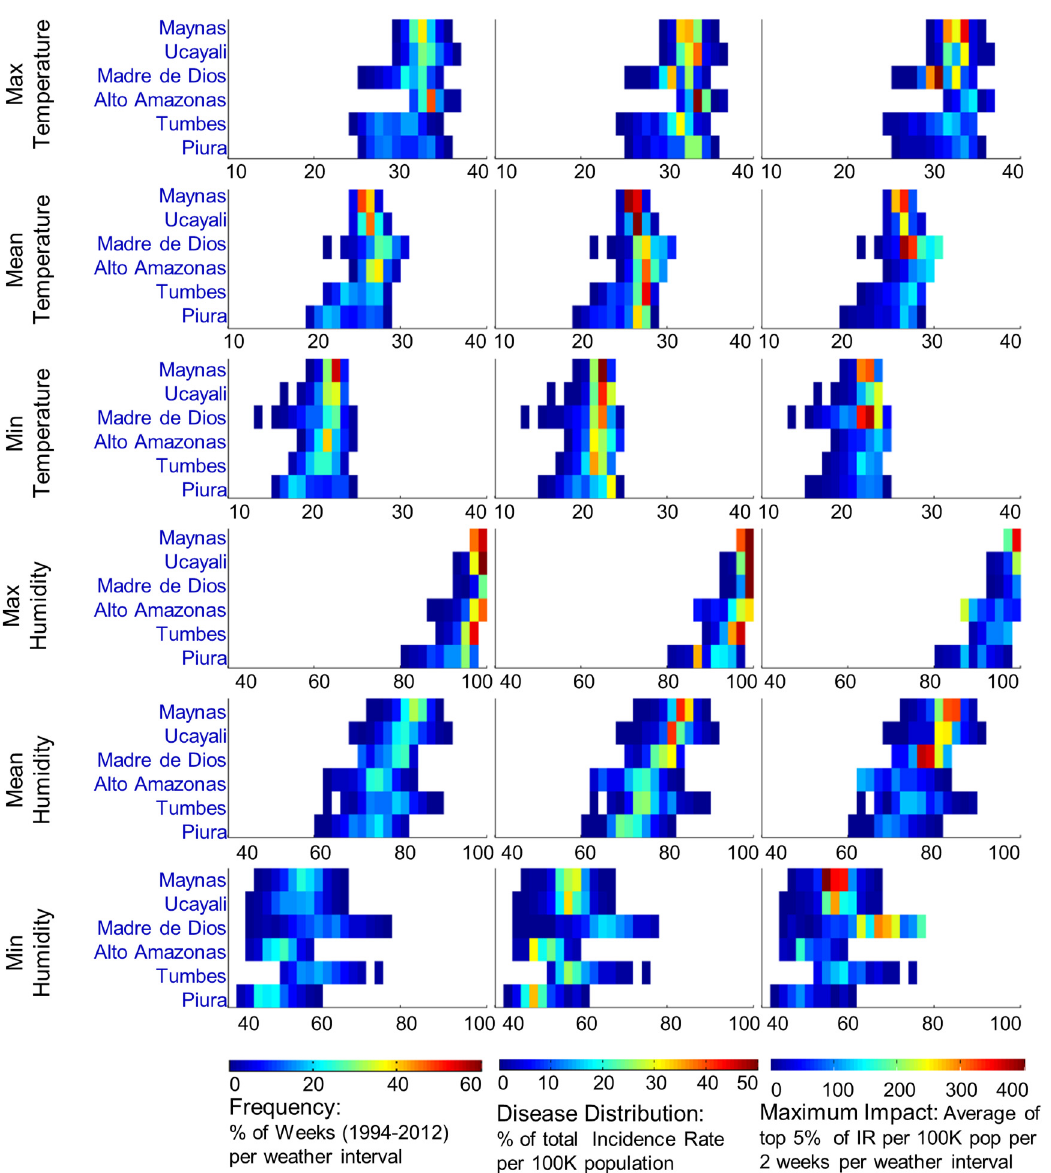
Fig 6. Comparison of dengue distribution by weather component across 6 high transmission locations in Peru. Left column: Annual frequency of weather interval per location is shown for each weather component. Grid interval is 1°C for temperature and 2% for humidity. Center column: distribution of cumulative incidence rates (1994 – 2012) across weather intervals for each location is shown for each weather component. Right column: Maximum dengue impact per weather interval is shown for each location, 1994 –